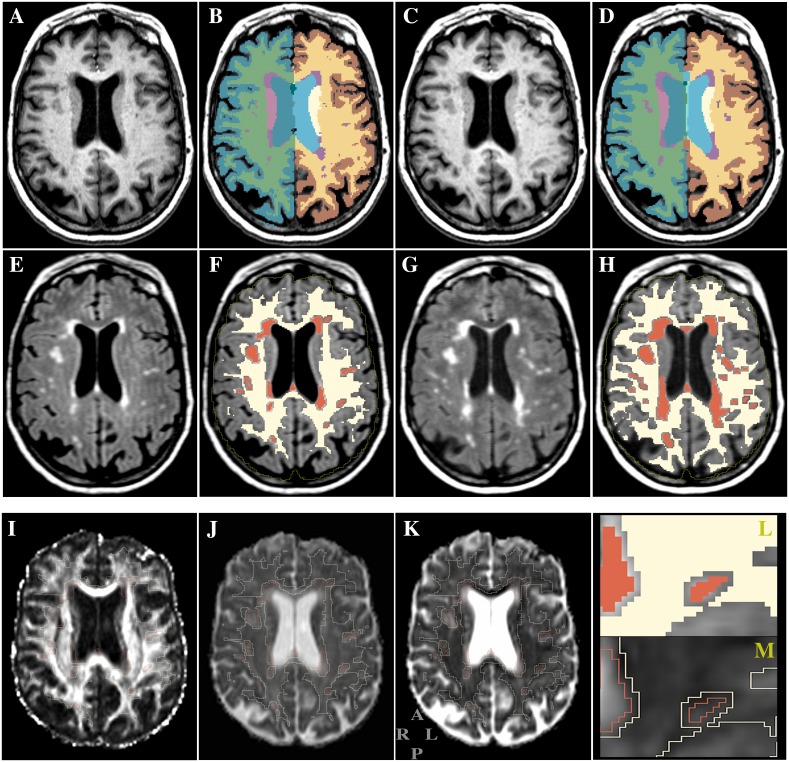
Example of structural and diffusion MR images from the study.Panels show the same brain region in axial view at baseline (A-B, E-F, I-K) and at 4-years (C-D, G-H). Top row: T1-weighted MPRAGE images. Middle row: T2-weighted FLAIR images. Panels B and D show the brain tissue segmentation maps (parc) obtained with FreeSurfer [37]. The parc WM and the WMH maps were merged as shown in F (baseline) and H (4 years) where NAWM (eroded) is indicated in light yellow and WMH in red. We used these (i.e. F and H) as masks to measure the diffusion indices within the NAWM and WMH compartments. The yellow line in panels F and H represents the outline of the intracranial cavity. Bottom row: panels show an example of diffusion maps from the baseline time point. The outline-only of NAWM and WMH map in panel F is overlaid on the FA (I), AD (J) and RD (K) images. The two small panels at bottom right show a close view of a section of the overlaid mask as filled (L, from panel F) and outlined (M, from panel K). Standard radiological orientation is shown at bottom left of panel K with A = anterior; R = right; L = left; P = posterior.